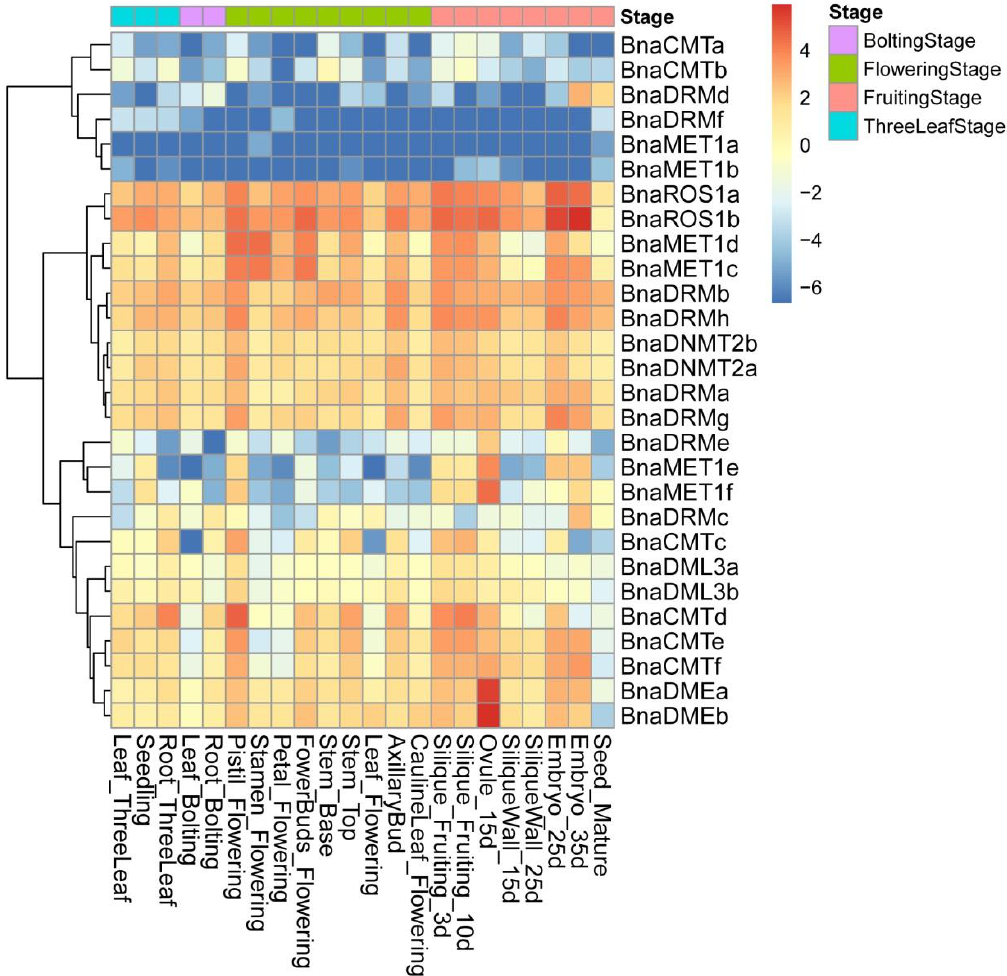
Figure 4. Heat map of rapeseed DNA-MTase and DNA-deMTase families’ genes expression patterns across tissues. Color scale bar at the top of each heat map represents log 2 -transformed FPKM (fragments per kilobase of exon per million fragments mapped) values for each gene, with warmer colors denoting higher expression. Tissues are divided into four periods according to the growth process: three leaf stage, bolting stage, flowering stage, and fruiting